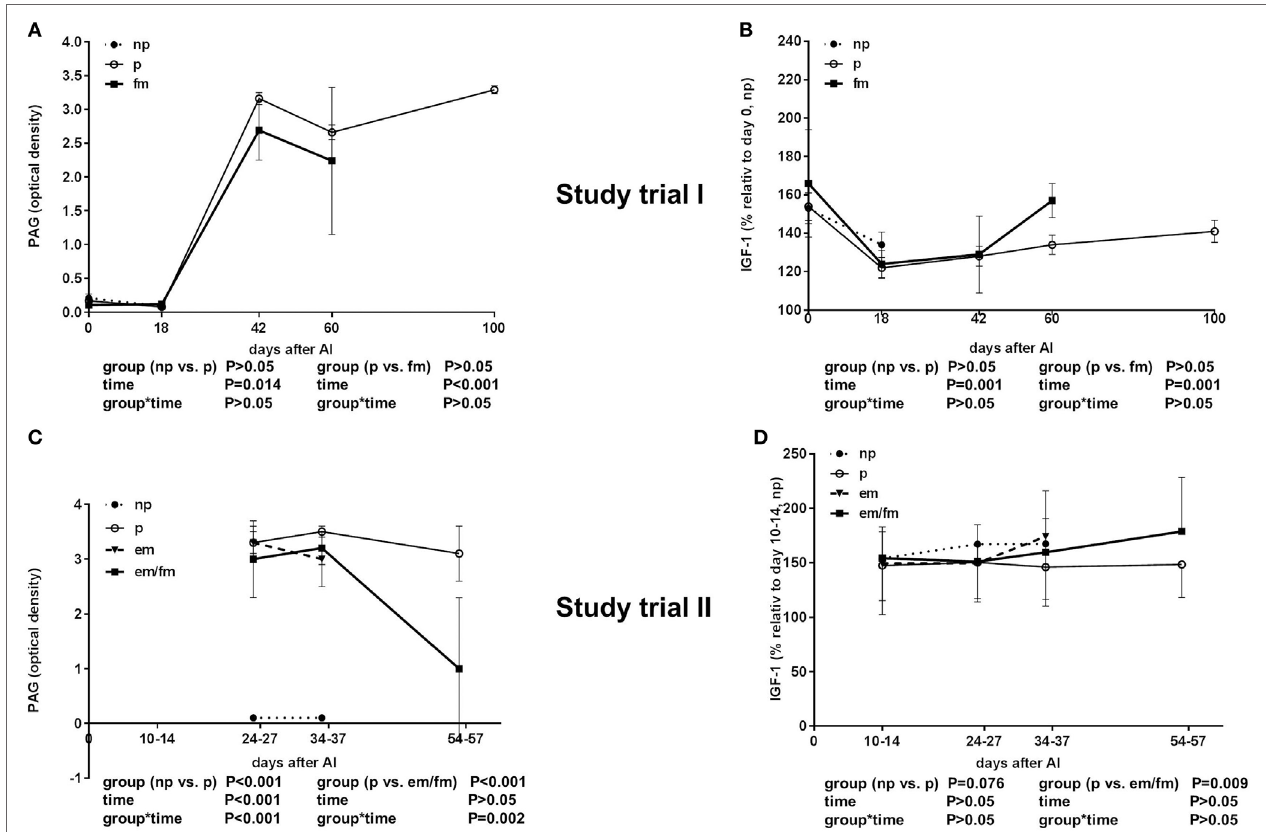
FigUre 2 | Semi-quantitative pregnancy-associated glycoproteins (PAG) values given in optical density (OD) units and insulin-like growth factor 1 (IGF-1) concentrations. (a,B) Study trial I in not pregnant [np, n = 43, day of AI (0) and 18 days after AI] and pregnant (p, n = 34, day of AI, and 18, 42, 60 and 100 days after AI) pluriparous Holstein–Friesian cows as well as cows with fetal mortality (fm, n = 4, day of AI and until day 60 after AI). (c,D) Study trial II in not pregnant (np, n = 20, 10–14 (IGF-1), 24–27, 34–37 days after AI) and pregnant (p, n = 30, 24–27, 34–37 and 54–57 days after AI) Holstein–Friesian cows as well as cows with embryo mortality (em, n = 7, 24–27, 34–37 days after AI) or late embryo/fetal mortality (em/fm, n = 8, 24–27, 34–37, and 54–57 days after AI). Values are given as mean ±